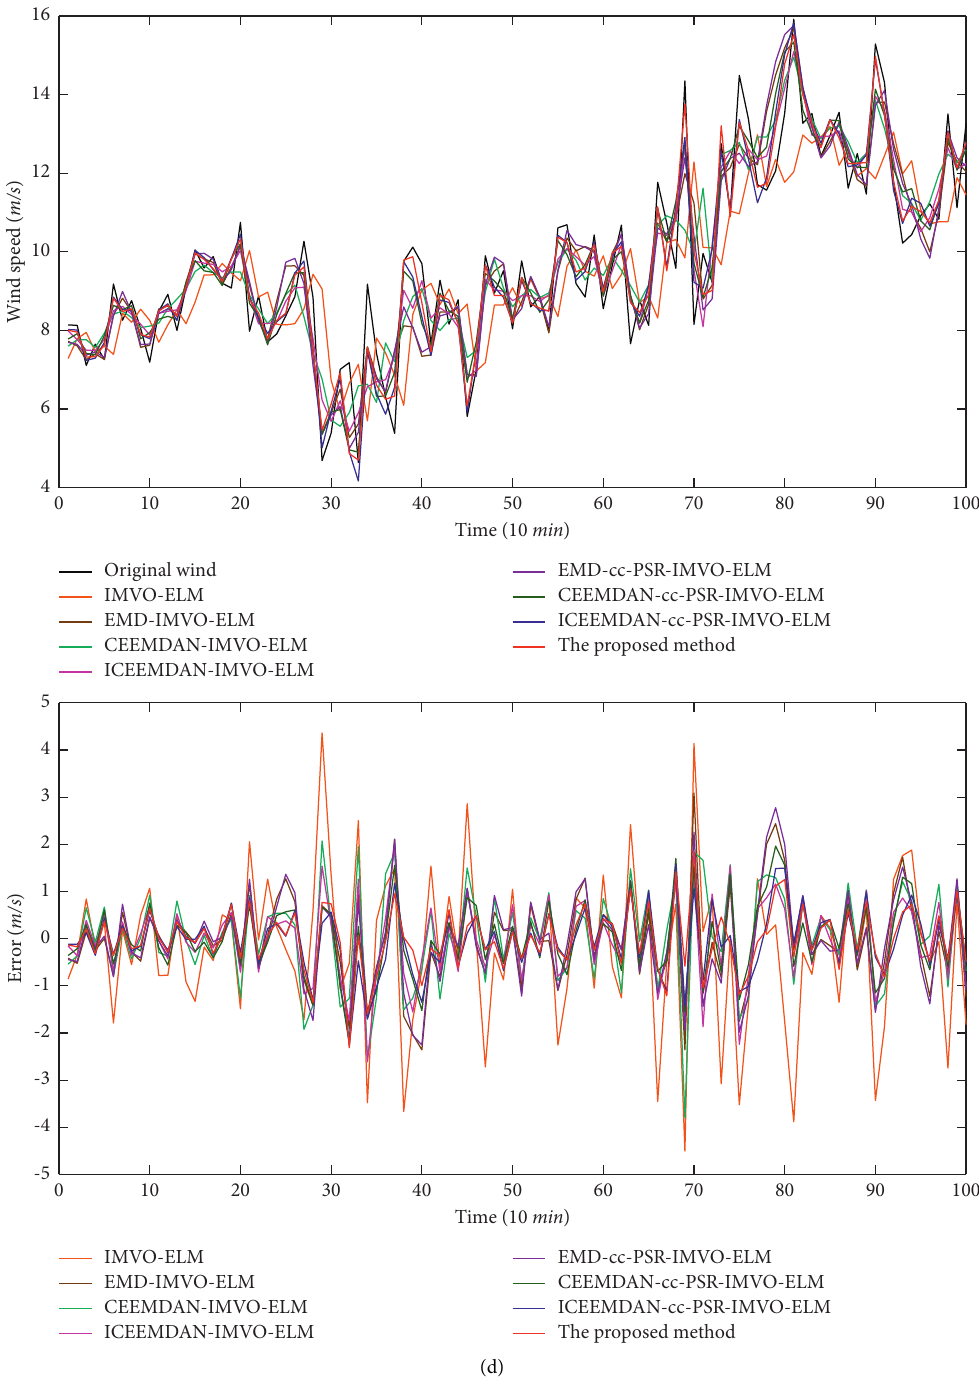
Figure 6: Forecasting results and error based on different predication methods. (a) Forecasting results and error of dataset A. (b) Forecasting results and error of dataset B. (c) Forecasting results and error of dataset C. (d) Forecasting results and error of dataset